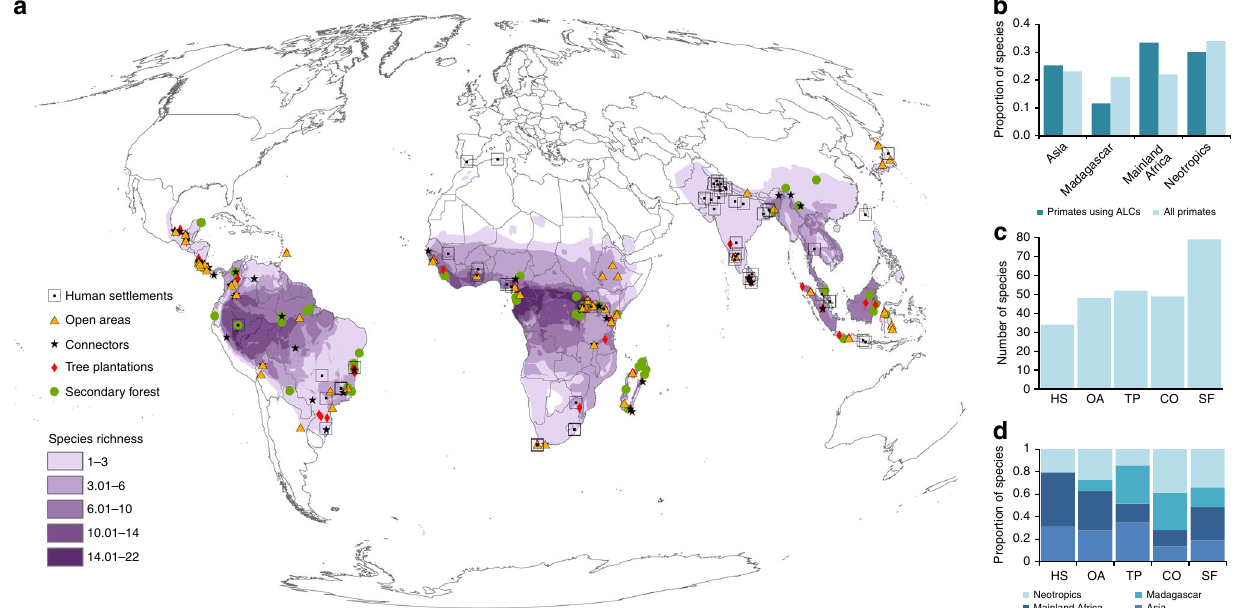
Fig. 1 Geographic distribution of studies reporting the use of different anthropic land covers (ALCs) by primates. Spatial location of each study and global pattern of primate species richness ( a ). Proportion of species using ALCs ( n = 147 species) compared to the total proportion of species ( n = 504 species) in each biogeographic realm ( b ). African primates were classi fi ed in two groups, those from mainland Africa and those from Madagascar, because these two land masses span the distribution of two highly divergent primate suborders (catarrhines and strepsirrhines, respectively). Number of primate species recorded using each of fi ve ALCs ( c ). Proportion of primate species using each ALC type in each realm ( d ). ALCs are categorized as human settlements (HS), open areas (OA), tree plantations (TP), connectors (CO), and secondary forests (SF). Species richness data in (A) was extracted from Pimm et al. 58